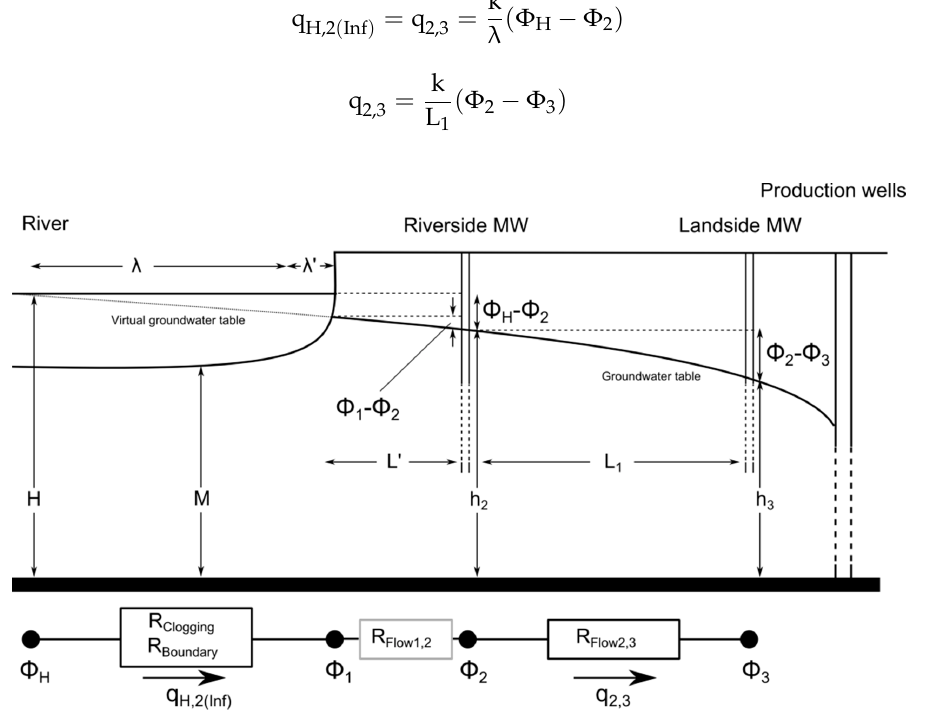
Figure 4. Geohydraulic scheme for the calculation of λ using the fragment approach (R = resistance).